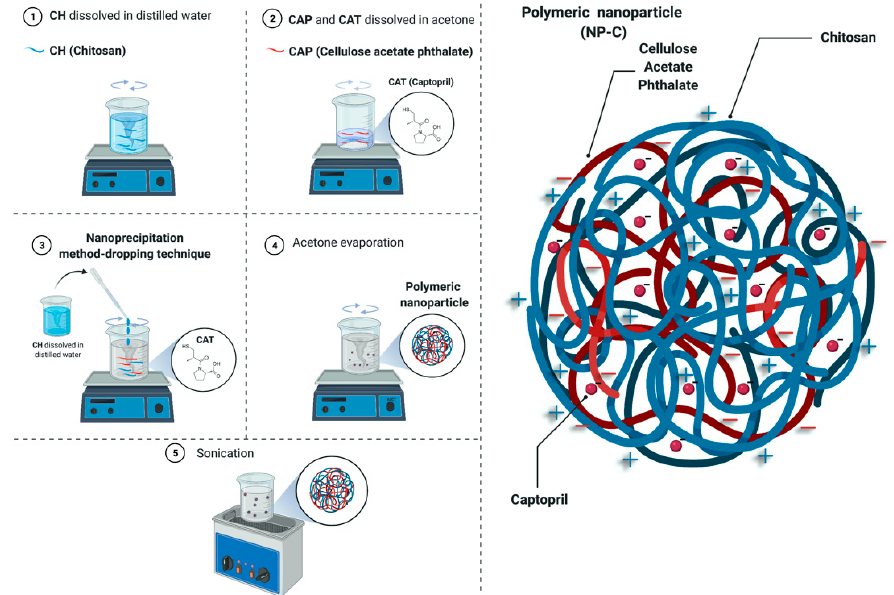
Figure 9. Nanoprecipitation method–dropping technique. Created with BioRender.com.